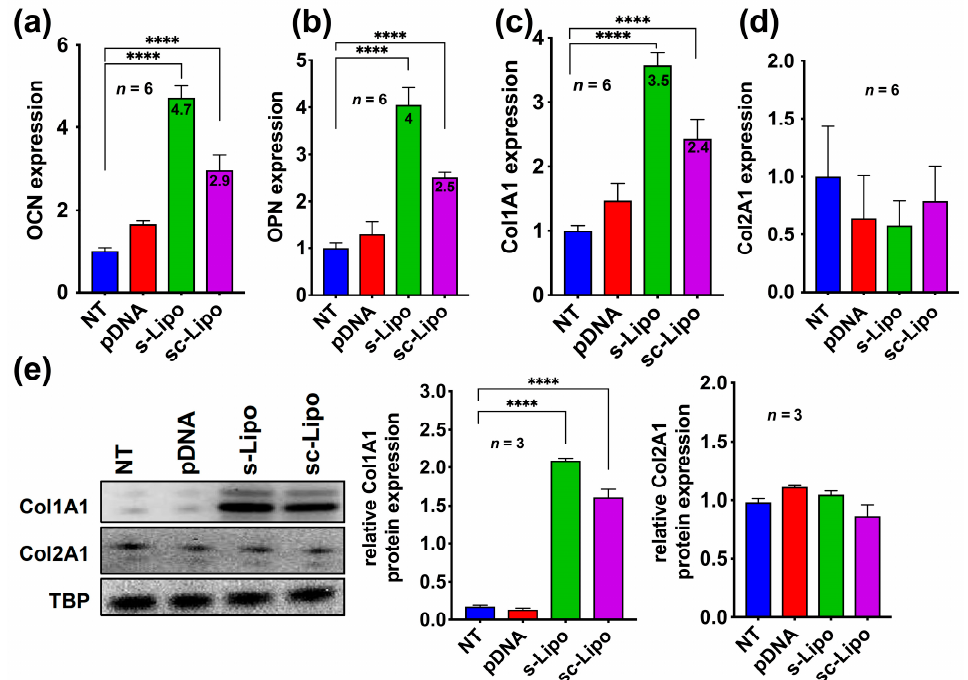
Figure 5. In vitro evaluation of osteogenic differentiation of hMSCs transfected with BMP-2 plasmid followed by encapsulation in HA hydrogels for 21-days. ( a ) Quantitative RT-PCR analysis indicating the expression profiles of late osteogenic markers, osteocalcin (OCN) ( b ) osteopontin (OPN) and ( c ) collagen-1 (Col1A1) after 21-days of the experiment. ( d ) Expression profile of chondrogenic marker collagen-2 (Col2A1) after 21-days of the experiment. TBP was employed as an internal control to normalize BMP-2 mRNA expression. Gene expression values are stated as fold change relative to controls. Mean values ± SD of 2 independent experiments done in triplicates ( n = 6) are shown ( e ) Western blot analysis indicating the expression of Col1A1 and Col2A1 as a result of transfection with BMP-2 in 3D. Col1A1, Col2A1, and TBP-specific bands were quantified by ImageJ software. Both Col1A1, and Col2A1 protein expression levels were normalized to TBP values. Mean values ± SD of three independent experiments are shown. Statistical analysis was performed using one-way ANOVA with Bonferroni’s multiple comparison corrections (**** p < 0.00001). The abbreviation NT = non-treated cells; pDNA = plasmid DNA alone; s-Lipo = Lipofectamine TM 2000 assisted transfection of cells in suspension followed by encapsulation in HA-hydrogel; sc-Lipo = Lipofectamine TM 2000 assisted transfection of cells in suspension followed by centrifugation and subsequent encapsulation in HA-hydrogel; TBP = TATA-binding protein.